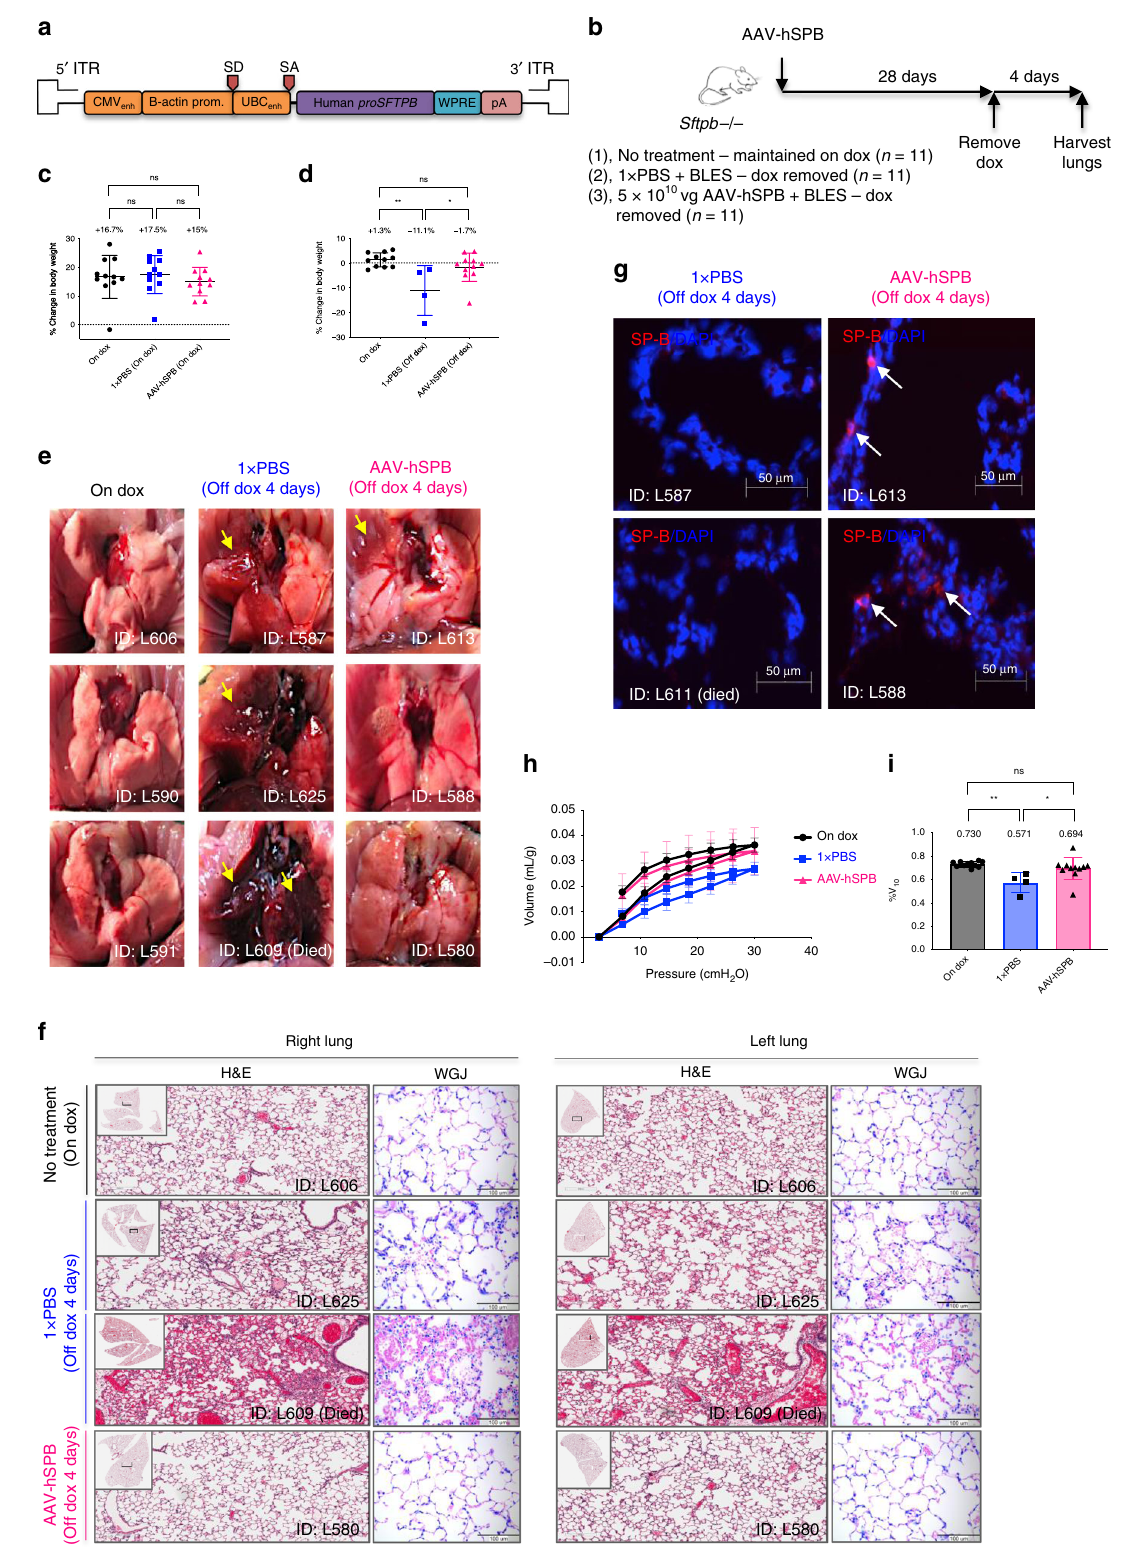
disease can develop when other factors reduce their remaining SP-B levels 36 . An alternative therapeutic strategy for SP-B de fi - ciency is genome editing and AAV6.2FF represents a potential vector for delivery of gene editing constructs into AT2 cells or their